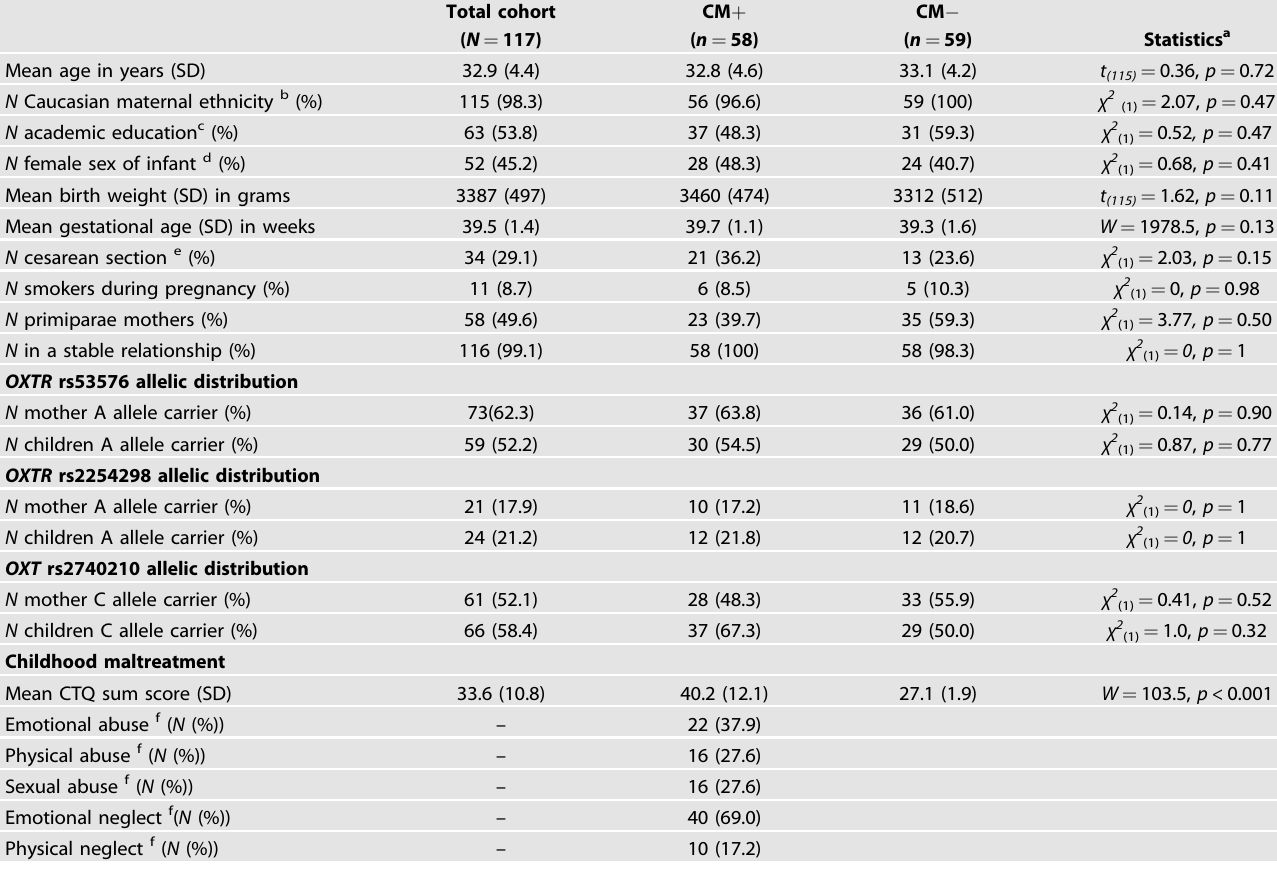
Table 1. Demographic and biological